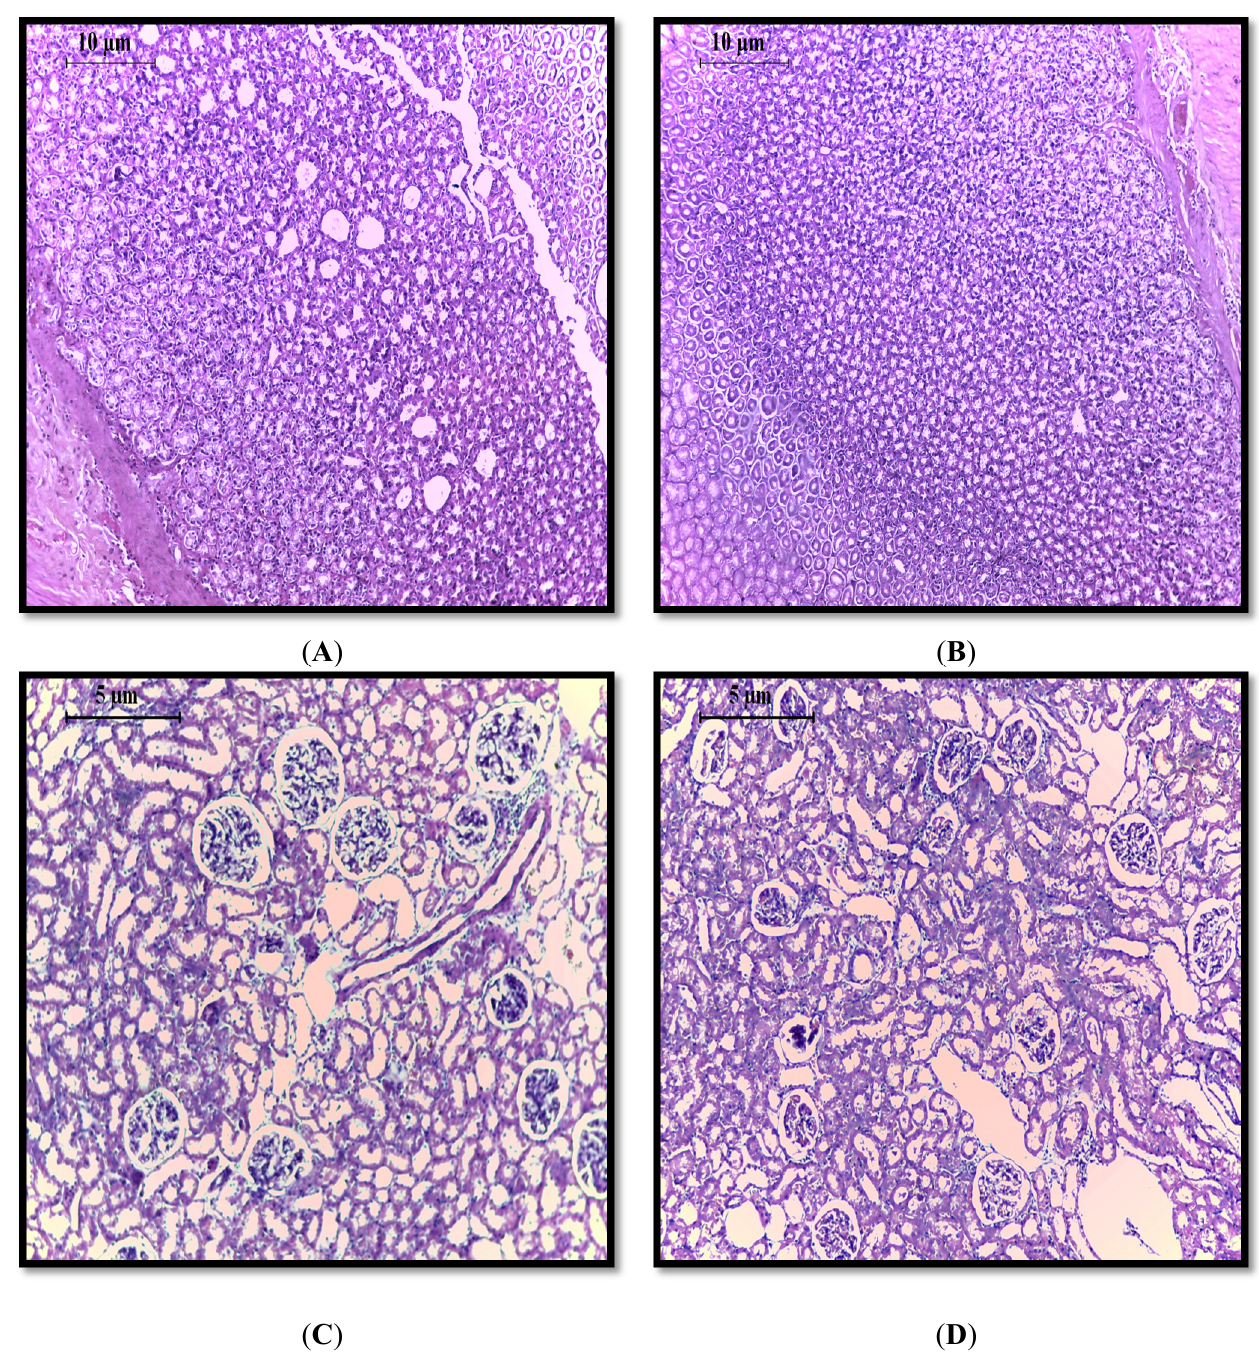
Figure 3. Histological appearance of tissue sections of various organs. ( A ) section of stomach of test animal; ( B ) section of stomach of control animal; ( C ) section of kidney of test animal; ( D ) section of kidney of control